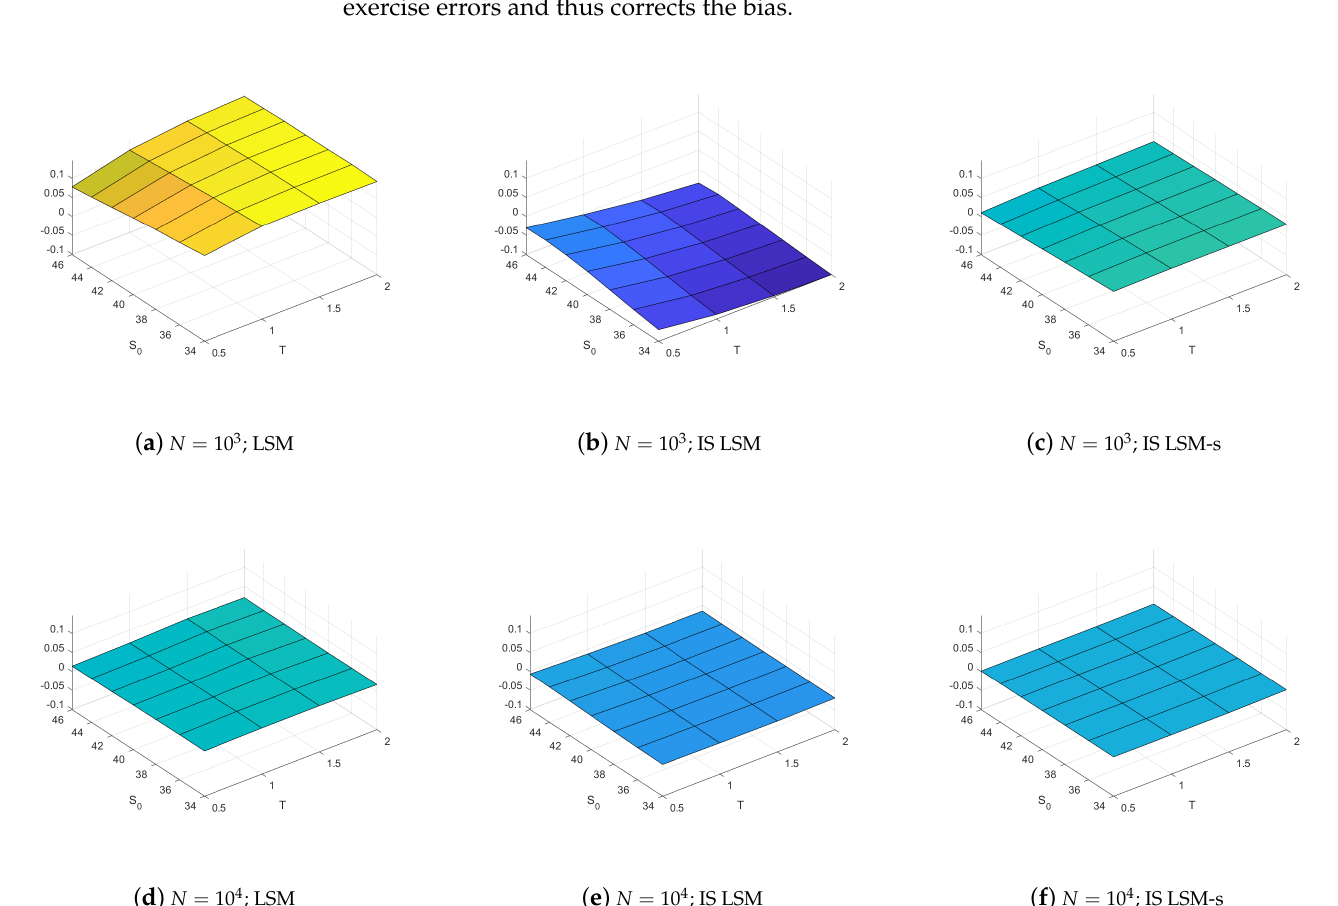
Figure 2. Bias without and with optimal drift. Bias results are calculated with respect to a Cox et al. (1979) binomial tree solution for the LSM and the LSM-s estimators. The left column illustrates results for the LSM without importance sampling, the center column LSM with importance sampling, and the right column LSM-s with importance sampling. The top row presents results for estimators using 1000 paths and the bottom row for 10,000